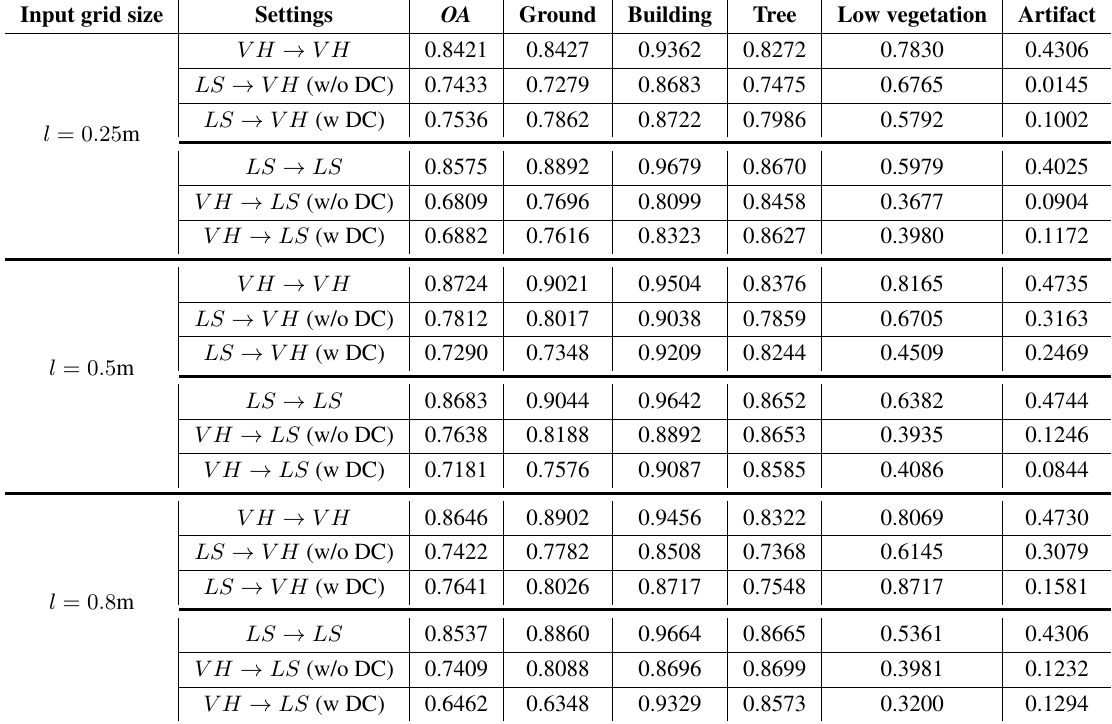
Table 3. Results with different input grid spacing. Data augmentation was carried out but intensity features were not used. OA decreased by 8 pp and 6 pp for LS → V H and V H → LS , respectively. Deep CORAL manages to mitigate that perform- ance drop, improving OA by 2.8 pp and 4.2 pp, correspondingly. However, its impact is again class-specific and the F 1 scores of several classes are decreased significantly. In particular, in the V H → LS test the F 1 scores for trees and buildings are lower than before, and the score for artifacts even drops to